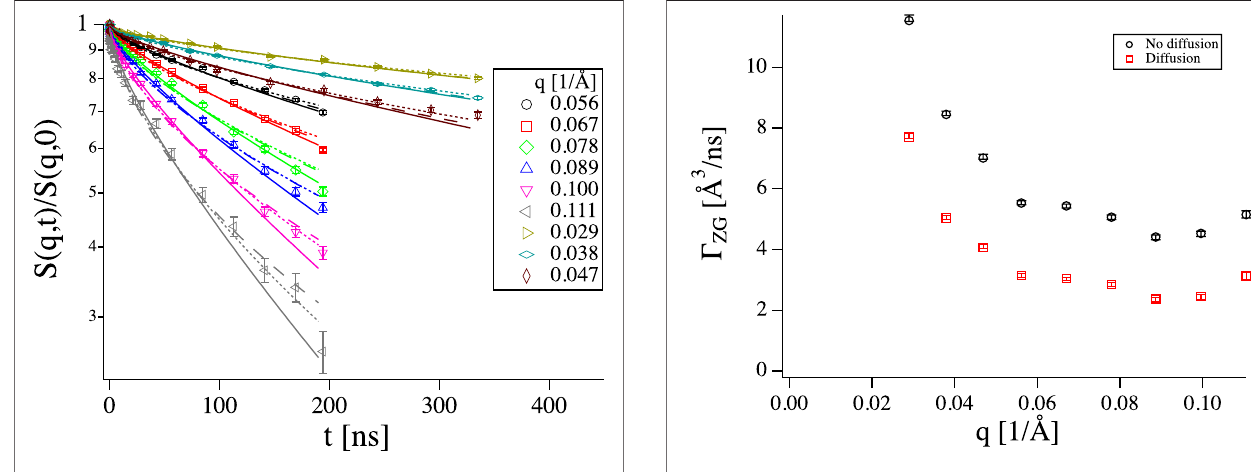
FIGURE 4 | Intermediate scattering function of the same vesicles as in Figure 3 with different fi ts: Dashed lines: Eq. 8, full lines: Eq. 7, dotted lines: Eq. 1. All fi t functions yield reasonable fi ts.